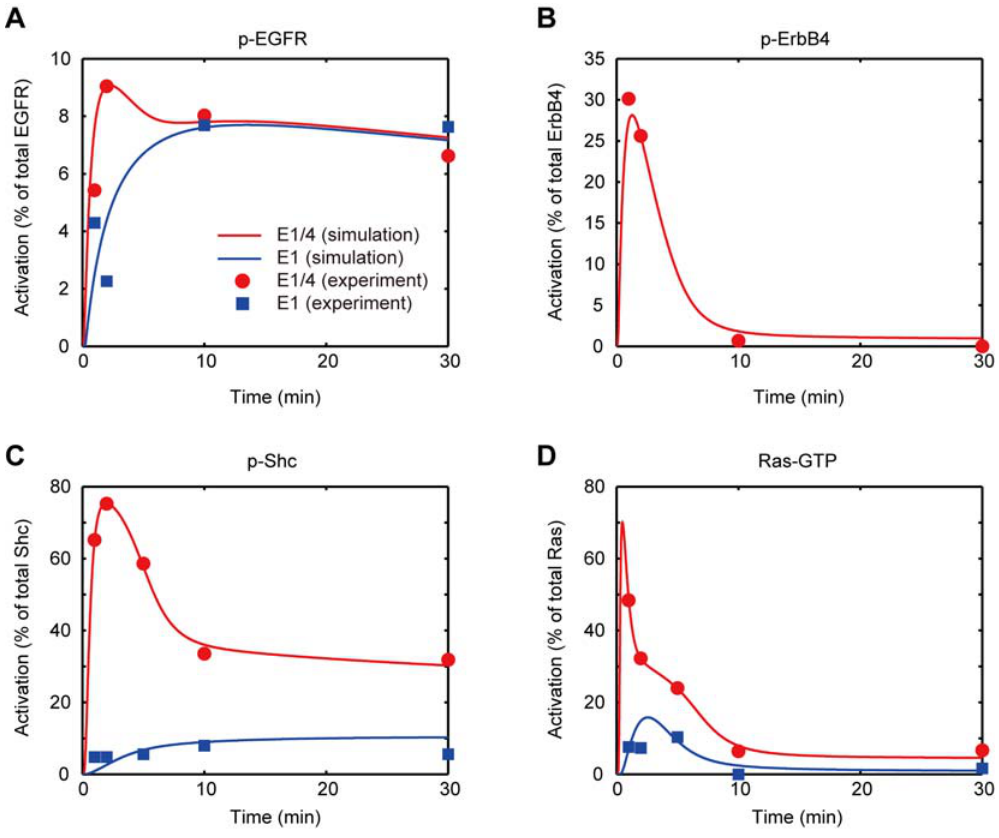
Figure 7. Time-course activity of signaling molecules with 10 nM EGF in ErbB signaling. The responses of the signaling molecules during 30 min are plotted with the corresponding experimental data listed in Table 1 (nos. 4 and 8–10). (A) Phosphorylated EGFR in E1 and E1/4 cells, respectively. (B) Phosphorylated ErbB4 receptor in E1/4 cells. (C) Phosphorylated Shc in E1 and E1/4 cells, respectively. (D) Ras-GTP in E1 and E1/4 cells, respectively. Blue and red lines indicate simulation data for E1 and E1/4 cells, respectively, and filled squares and circles indicate experimental data E1 and E1/4 cells, respectively. Graphs represent activity (% of total protein).